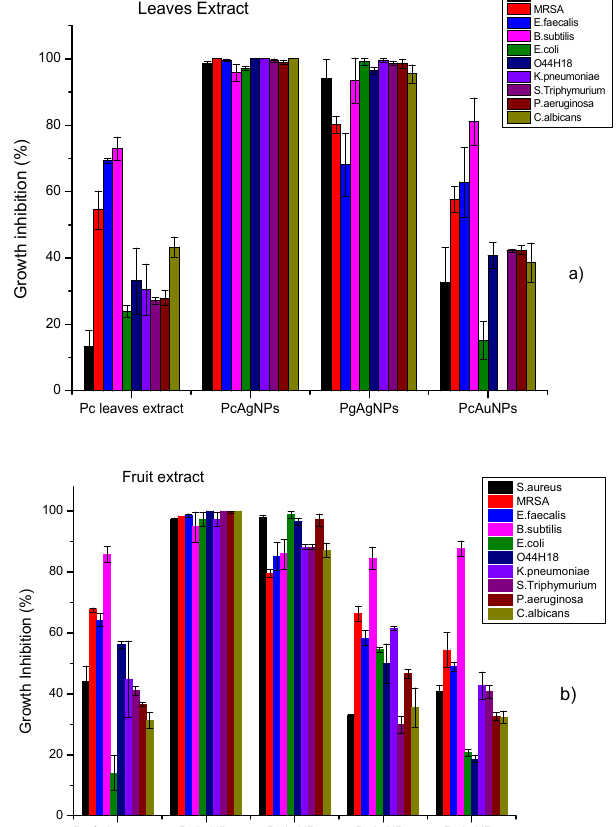
Figure 7. Antimicrobial activity of ( a ) leaves and ( b ) fruit extracts of Plinia cauliflora (“jabuticaba”) and their respective PcAg, PgAg, PcAu and PgAu nanoparticles against Staphylococcus aureus ATCC 25923, Bacillus subtilis ATCC 6633, methicillin-resistant Staphylococcus aureus (MRSA), Enterococcus faecalis , Escherichia coli ATCC 25922, Escherichia coli O44:H18 EAEC042, Klebsiella pneumoniae ATCC 700603, Salmonella Thiphymurium ATCC 14028, Pseudomonas aeruginosa ATCC 27853, and Candida albicans ATCC 10231 after 20hours of incubation with PcAgNPs and PcAuNPs indicated in Table 1. The error bar denotes the standard